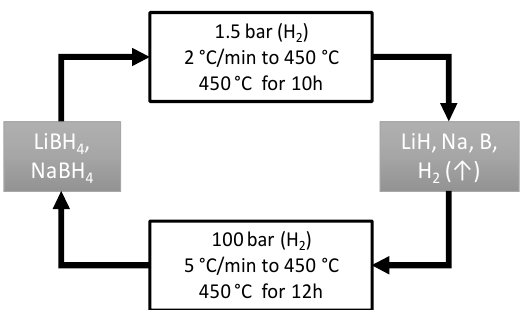
Figure 8. Schematic representation of the LiNa dehydrogenation/rehydrogenation process carried out with a custom-made Sievert apparatus. The amount of H 2 released by LiNa and LiNa composites was calculated after heating the material to 450 °C under 1.5 bar of H 2 pressure. The products were then re-hydrogenated at 450 °C under 100 bar of H 2 pressure. The cycle was repeated five times.